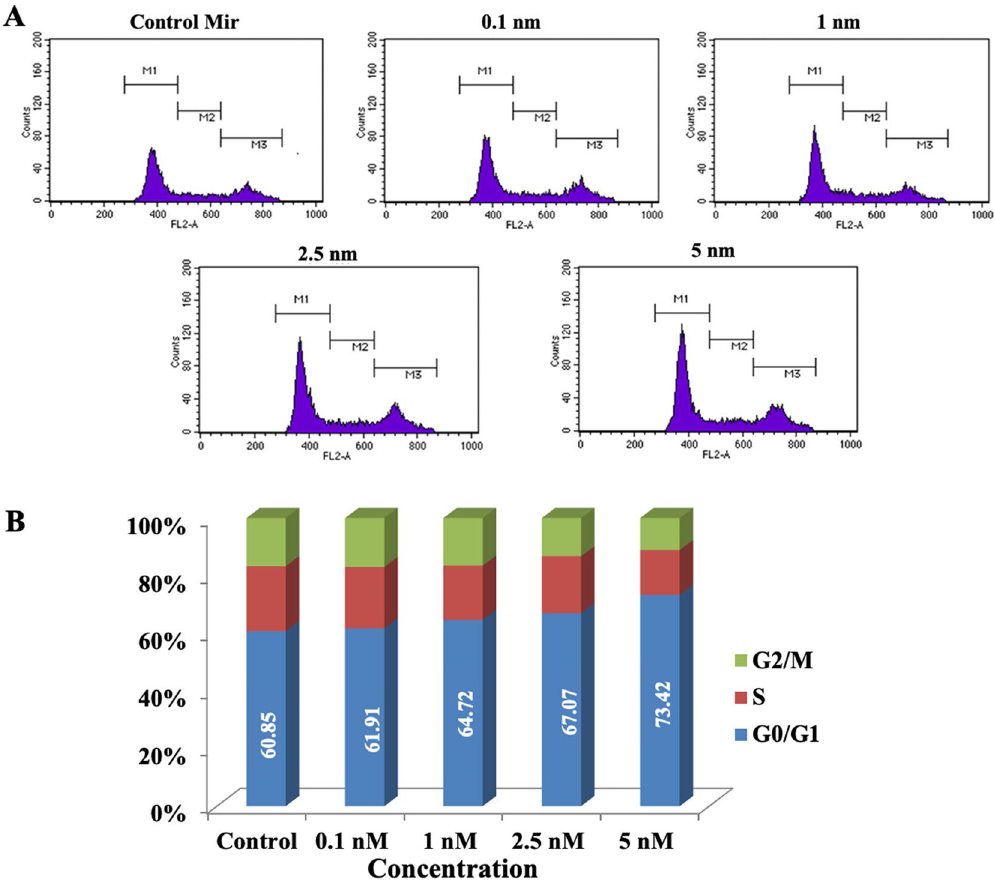
Figure 4. The cell cycle distribution analysis using flow cytometry in MCF-7 cells. ( A ) The cell cycle distribution histogram of cells treated with 0.1 nM, 1 nM, 2.5 nM and 5 nM of miRNA -206 mimic coated Au Nps for 24 h. ( B ) Graphical representation of cell cycle arrest after 24